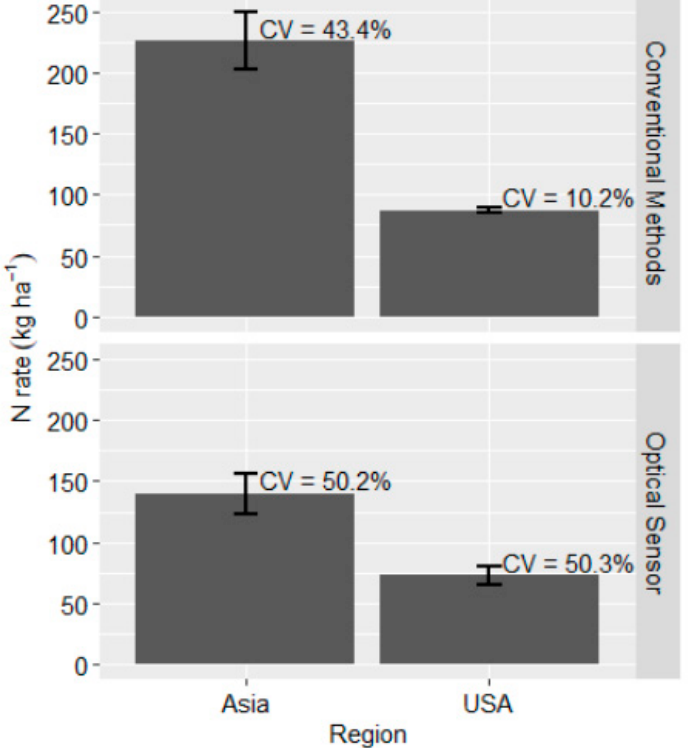
Figure 2. The quantity of nitrogen applied to winter wheat when using optical sensor and conventional methods of N management for USA and Asia. The error bar indicates standard error, while CV represents that stand coefficient of variation.